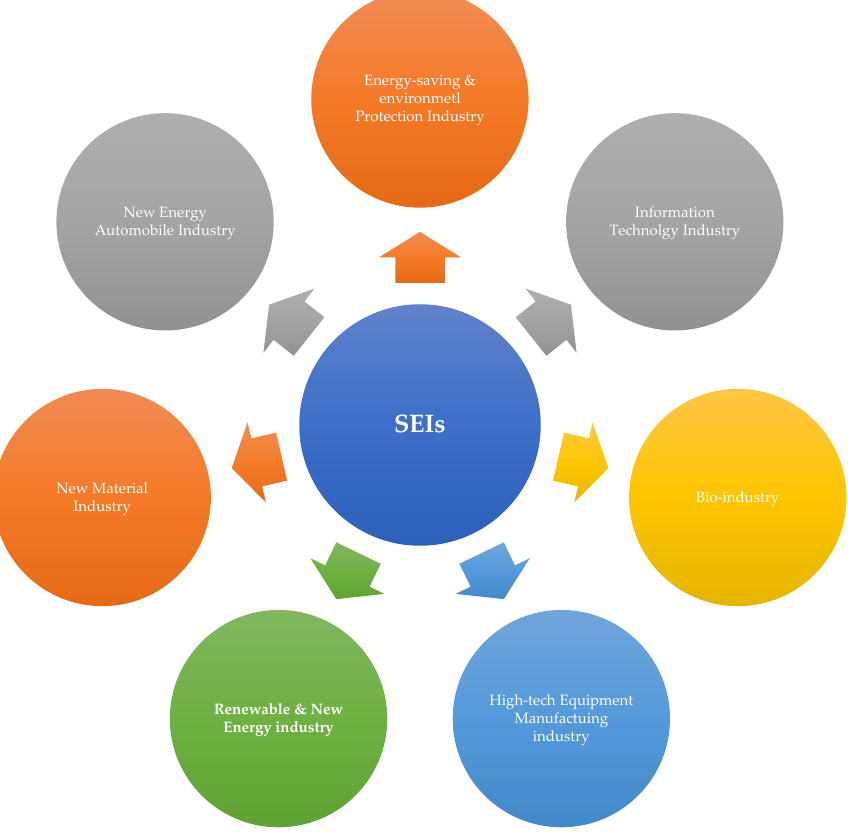
Figure 3. Diagram of China’s Seven Strategic Emerging Industries. Source: Organized by the author and source from